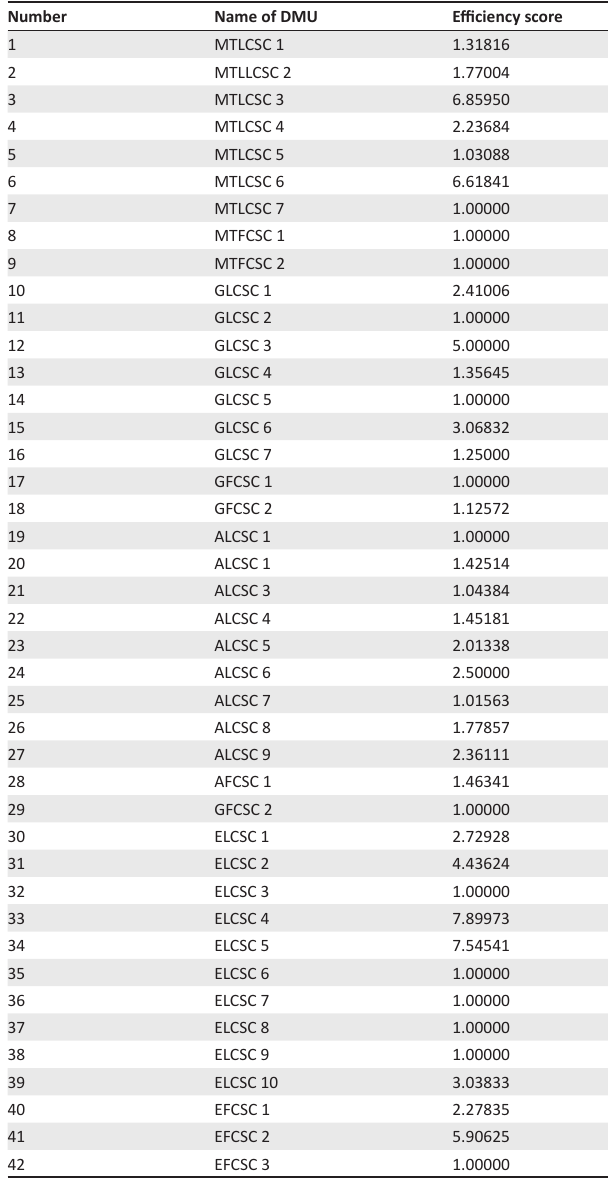
TABLE 1-A2: Results of output-oriented VRS model: Pure technical efficiency – CSC in Lagos state and FCT.